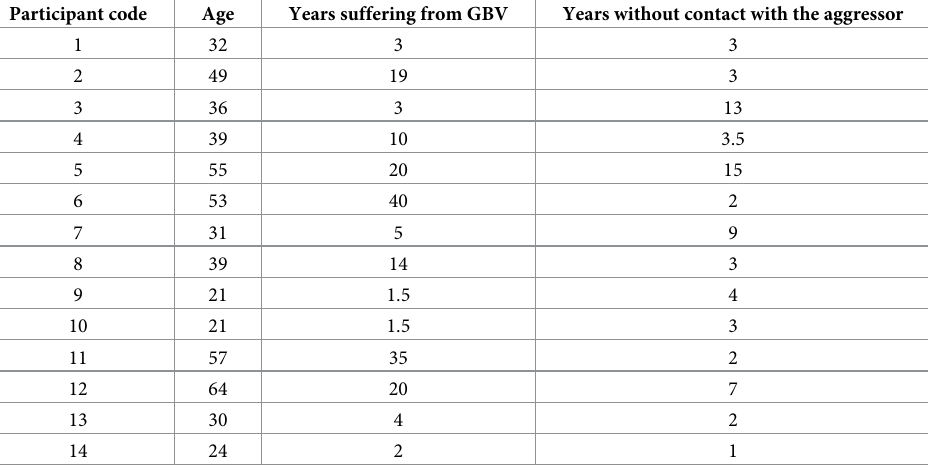
Table 2. Sociodemographic characteristics of the